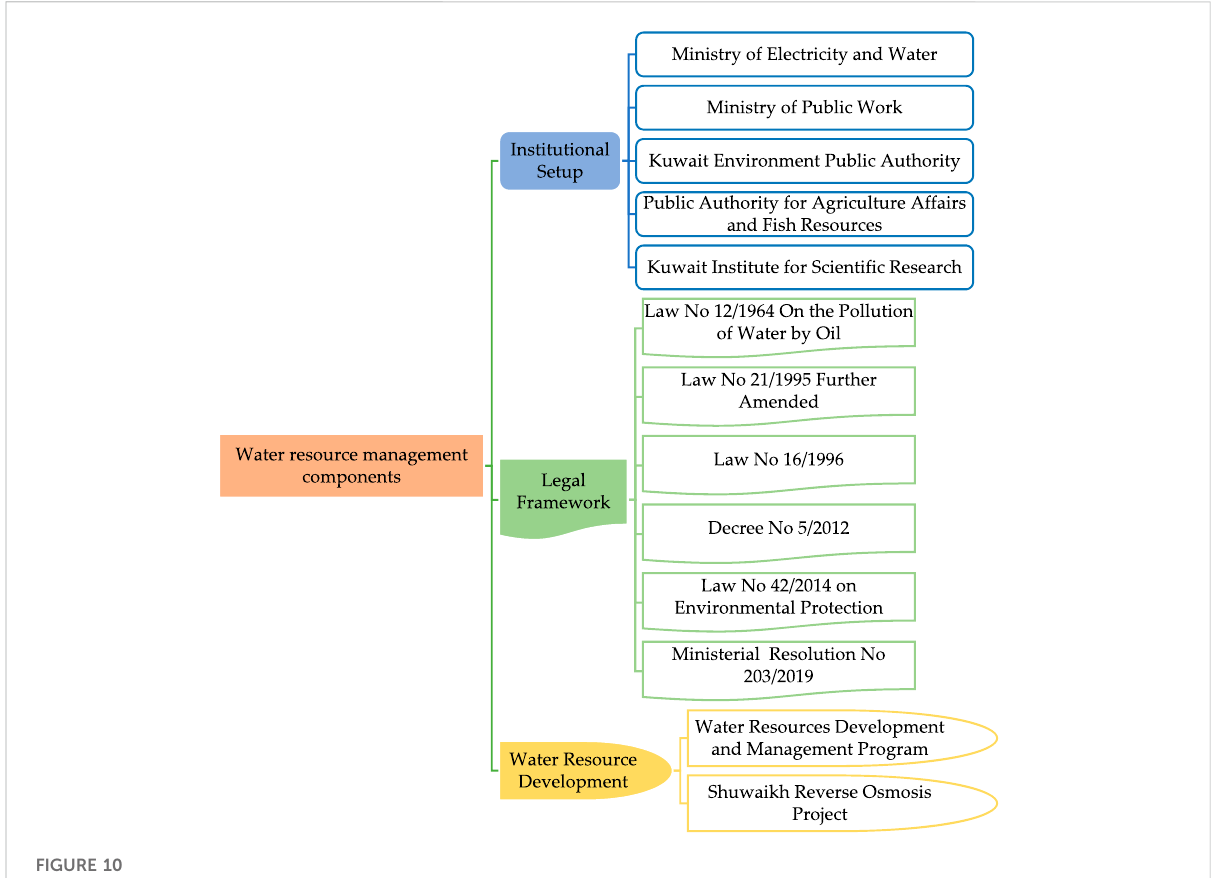
FIGURE 10 Water management governance framework of